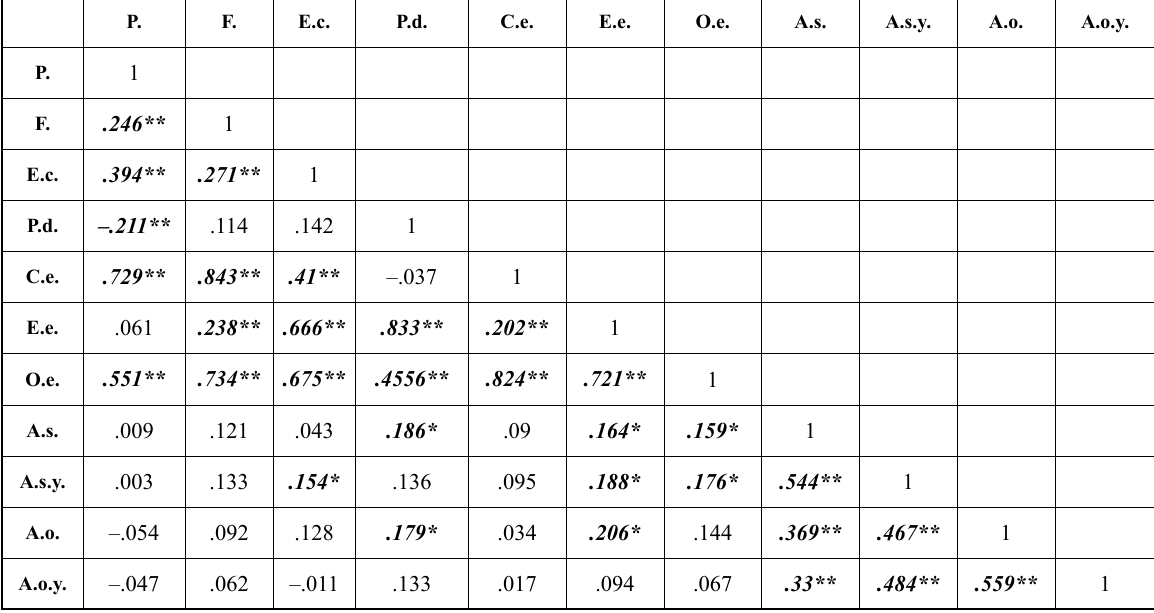
Table 7. Correlation matrix of subscales of Interpersonal Reactivity Index Scale and Revised Collet-Lester Fear of Death and Dying Scale, female